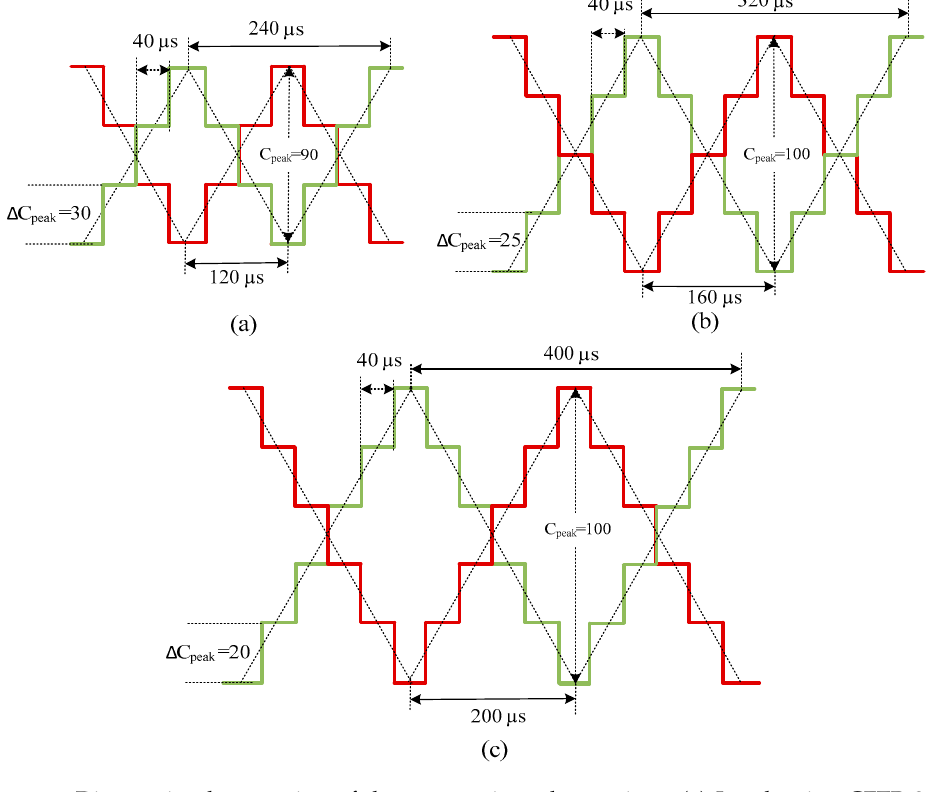
Figure 9. Discrete implementation of the upper triangular carriers: ( a ) Interleaving CFTR-3, ( b ) interleaving CFTR-4, and ( c ) interleaving CFTR-5. Electronics 2019 , 8 , x FOR PEER REVIEW